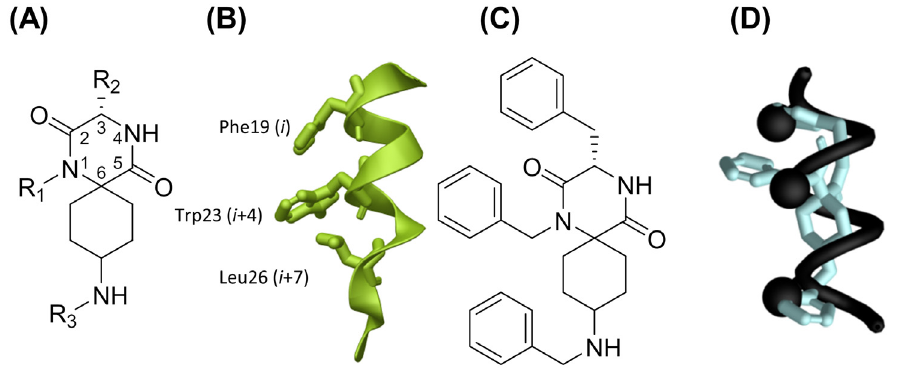
Fig 2. Spiro-DKPs as potential α -helix mimetics. ( A ) General structure of the target spiro-DKPs with numbering. ( B ) The side chains of Leu26 , Trp23 , and Phe19 in the p53 helix.( C ) Spiro-DKPs. ( D ) Superimposition of an Ala-helix (black), with a low energy conformation of a spiro-DKP B